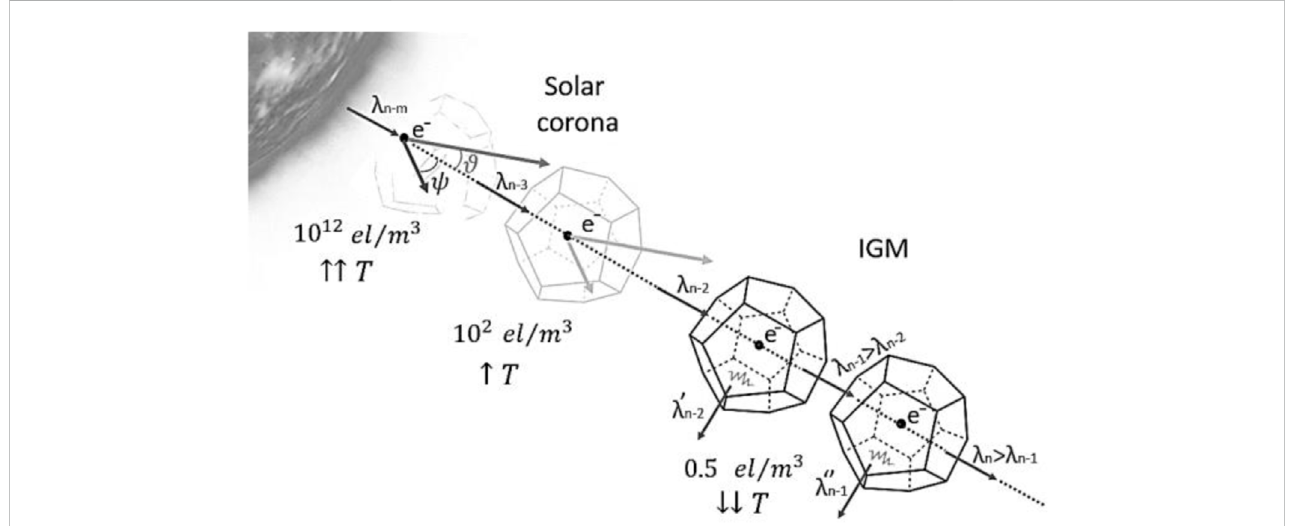
FIGURE 5 Schematization of the different interactions between photons and electrons from a stellar photosphere up to the IGM. The further the light travels from the source, the less dominant the Compton and Thomson scattering processes become. T indicates the temperature.